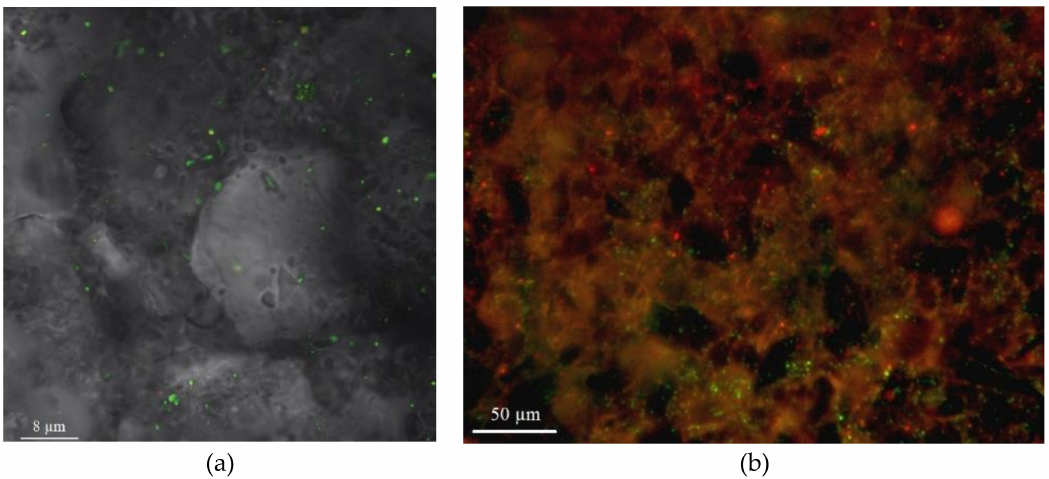
Figure 1. Zeolite surface before ( a ) and after ( b ) biofilm formation.